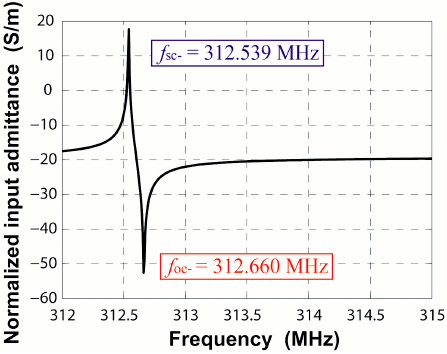
Figure 6. Input admittance of periodic IDT on ST-X quartz.